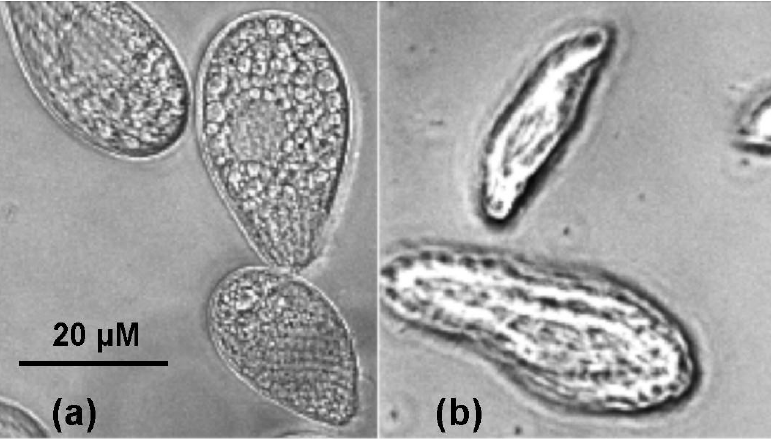
Figure 2. Images of T. pyriformis cells. The alive ( a ) and dead ( b ) cells are shown. The images were obtained using MBS-10 microscope at a magnification of 56.